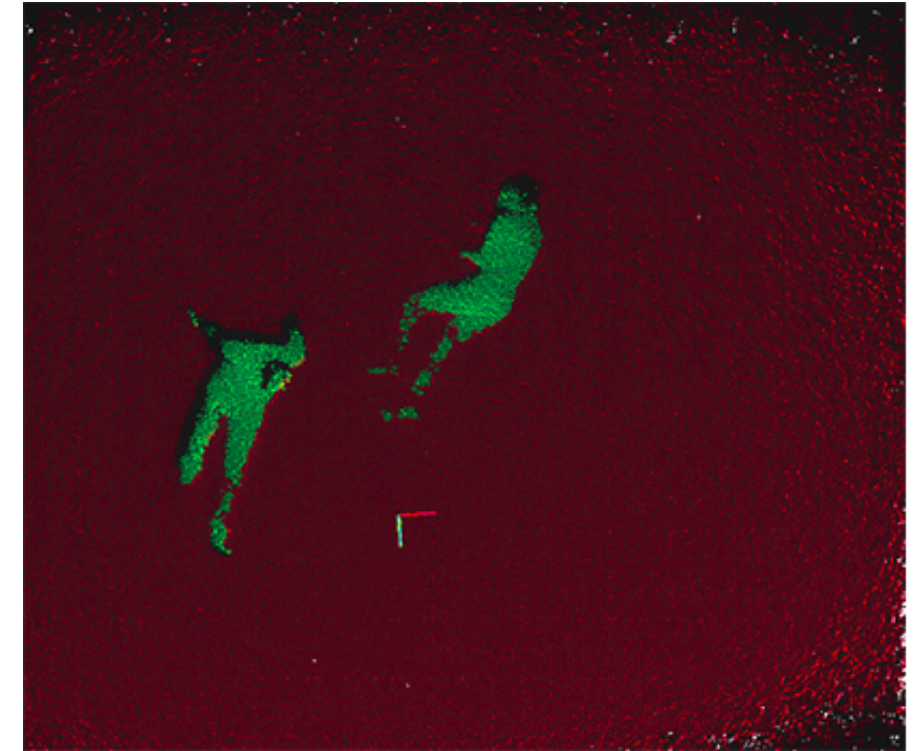
Figure 3. Plane segmentation for floor